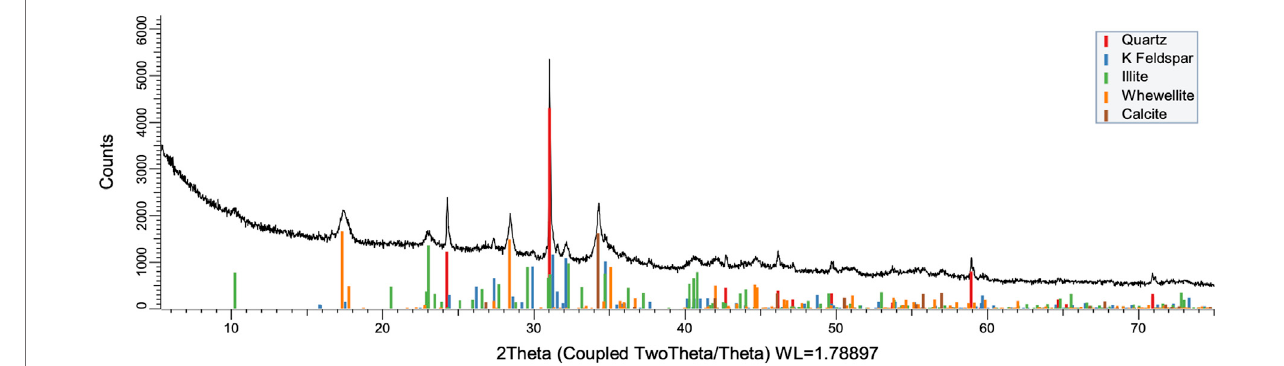
FIGURE 9 | XRD pattern of oxidation residue at 100 ° C and 1 h.